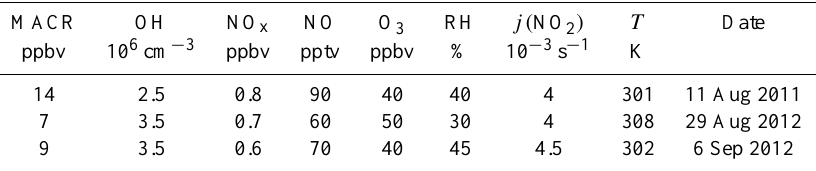
Table 1. Experimental conditions of the MACR oxidation experiments. Maximum values are given for MACR, and averaged values are given for the part of the experiment when MACR was present for the other parameters.